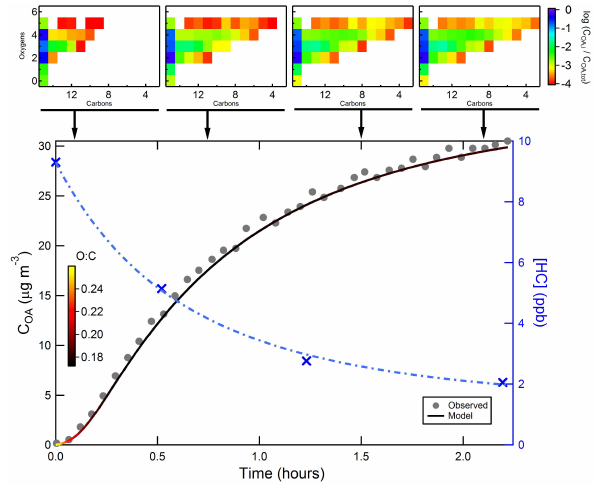
Fig. 9. The temporal evolution of C OA (left axis) and [HC] (right axis) for photoxidation of pentadecane under high-NO x conditions for the model (lines) and measurements (symbols: C OA = • and [HC] = *). Measured values are from Presto et al. (2010). The cal- culated curve is colored by the mean O:C of the OA. The small graphs show the distribution of products in the particle phase, col- ored by mole fraction, at various points throughout the reaction (in- dicated by arrows).